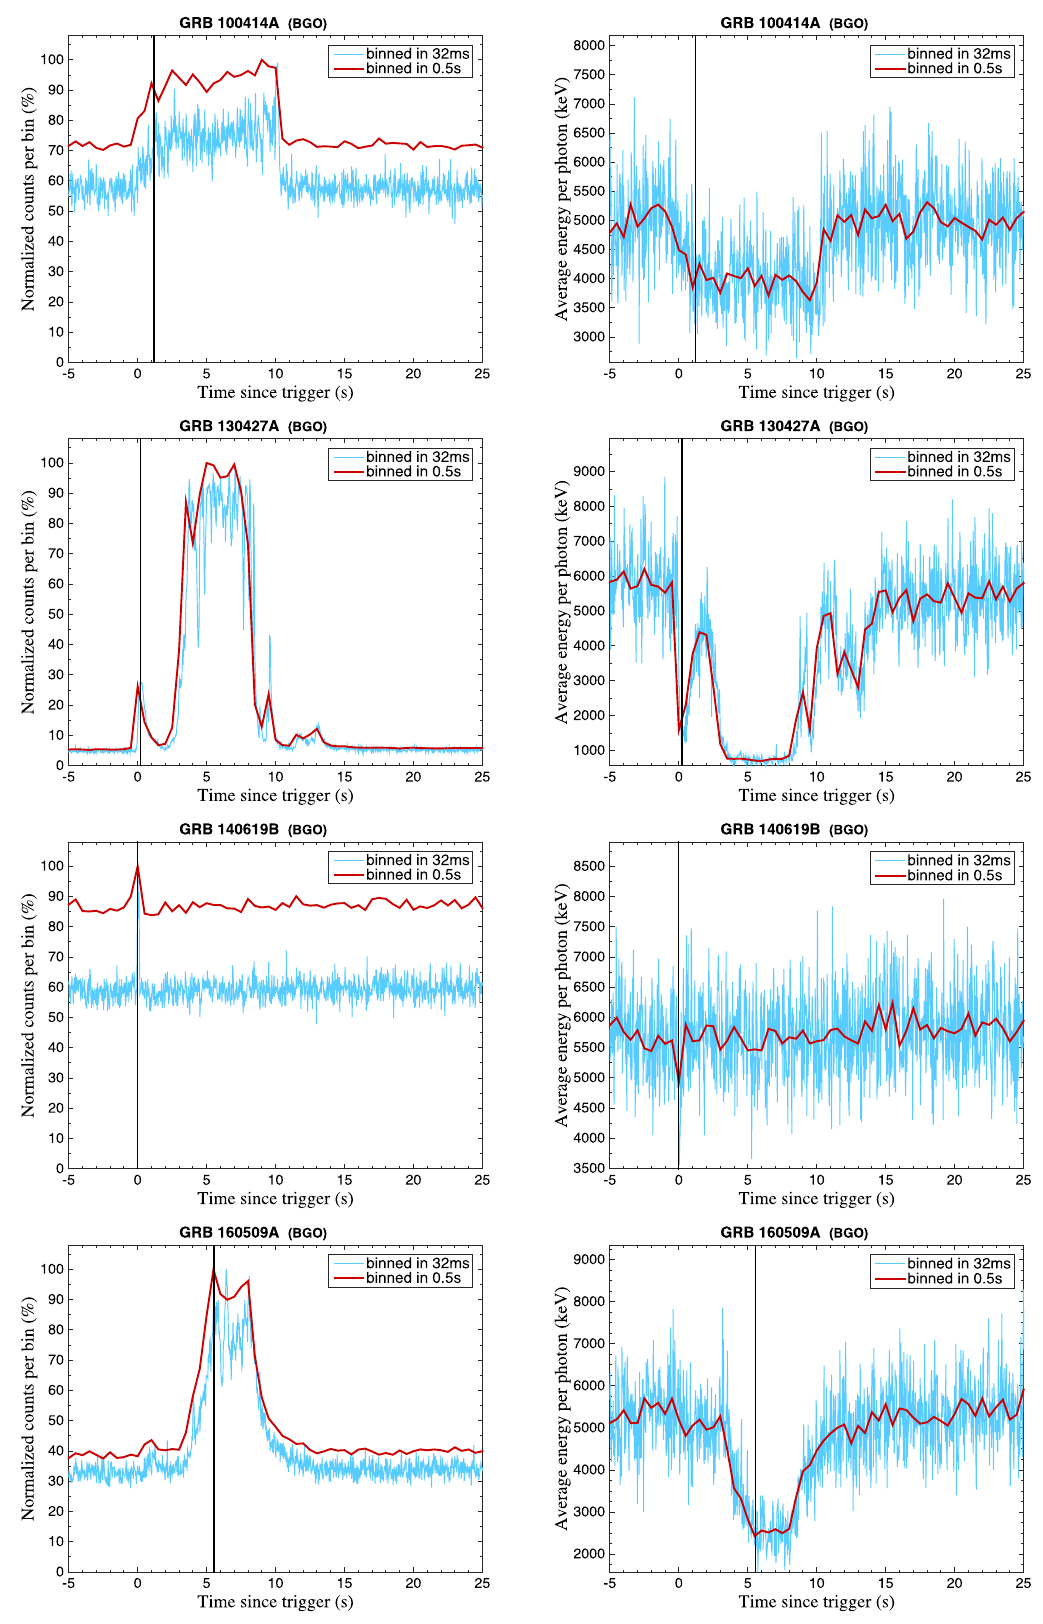
Fig. 20 Curves in Set-BGO (part 2): light curves and average energy curves of GBM BGO